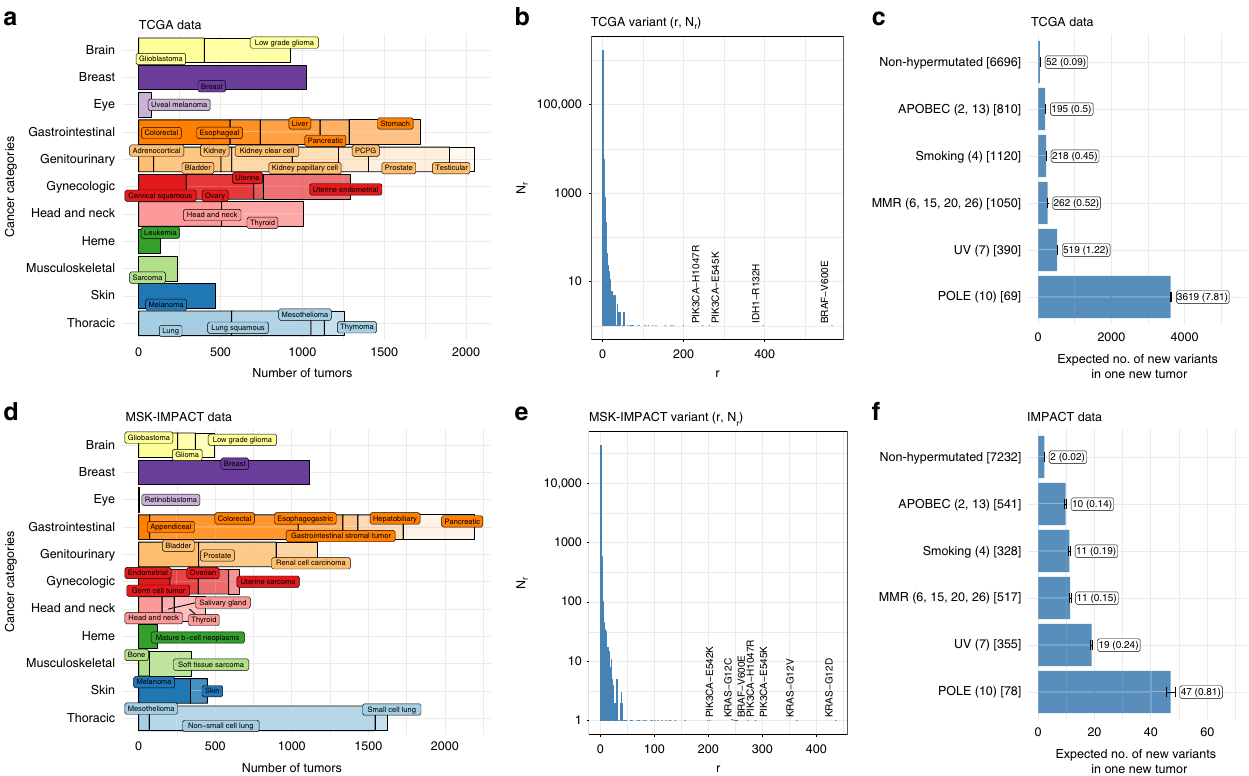
Fig. 1 The TCGA and MSK-IMPACT data. a , d Tissue type compositions for TCGA data ( a ) and MSK-IMPACT data ( d ) show differences in the respective tissue-speci fi c cohort sizes. b , e Variant frequencies ( r ) plotted against the associated number ( N r ) of variants with that frequency in TCGA ( b ) and MSK- IMPACT ( e ) data. More than 90% of the variants in either dataset are singletons, i.e., appear only once. c , f The smoothed Good-Toulmin estimated average numbers of new variants (whole-exome variants for TCGA, and variants of the 410 paneled genes in MSK-IMPACT) in a new tumor together with its standard error obtained separately for each tumor subgroup in TCGA ( c ) and MSK-IMPACT ( f ) are displayed. The numbers inside the boxes are the respective estimates (outside parentheses) and their estimated standard errors (inside the parentheses), and the error bars correspond to ±2 standard error bounds. The numbers within parentheses in the vertical axes labels indicate the SBS numbers belonging to each dominant signature group (e.g., APOBEC corresponds to SBS numbers 2 and 3) and the numbers inside the square brackets denote the cohort sizes of the associated group in the TCGA and MSK-IMPACT data